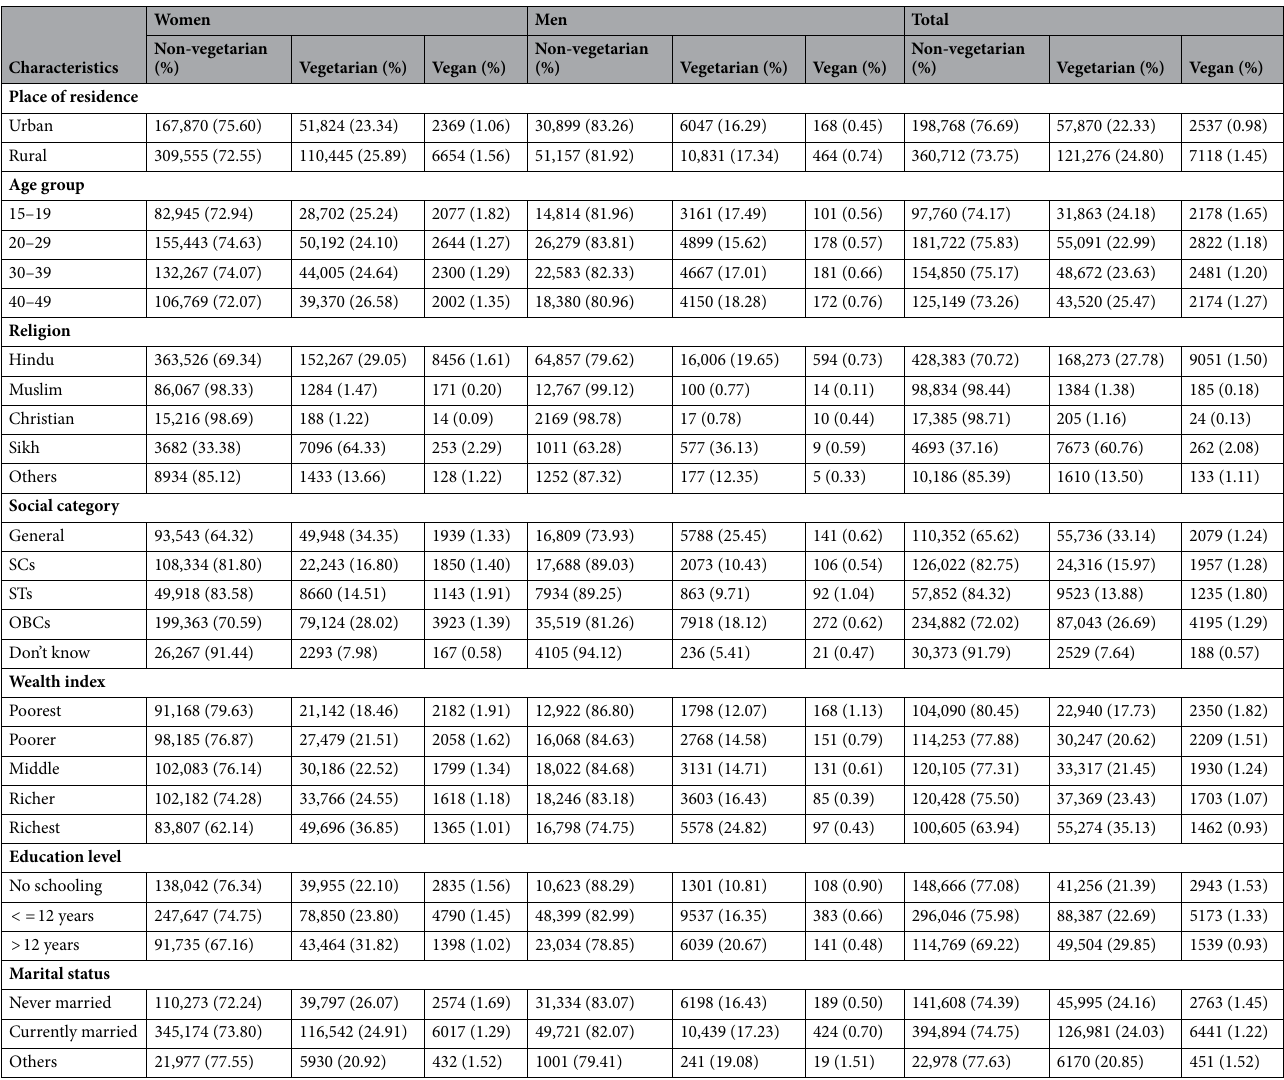
Table 3. Percentage distribution of different socioeconomic and demographic groups according to types of vegetarian diet consumption in women and men participants in National Family Health Survey, 2015–2016. All the values are weighted using sample survey weights from